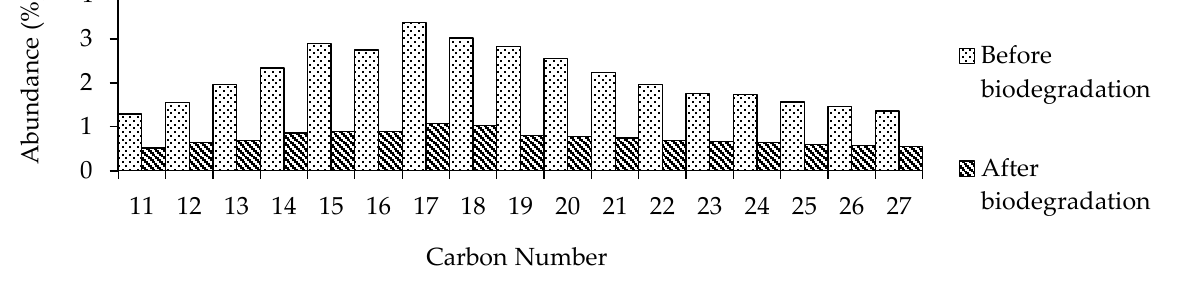
Figure 4. Content change of paraffinic compounds found in crude oil before and after biodegradation from GC-MS analysis. The abundance of linear alkanes with chain lengths between 11 and 27 carbon atoms in the oil phase before and after the biodegradation process.